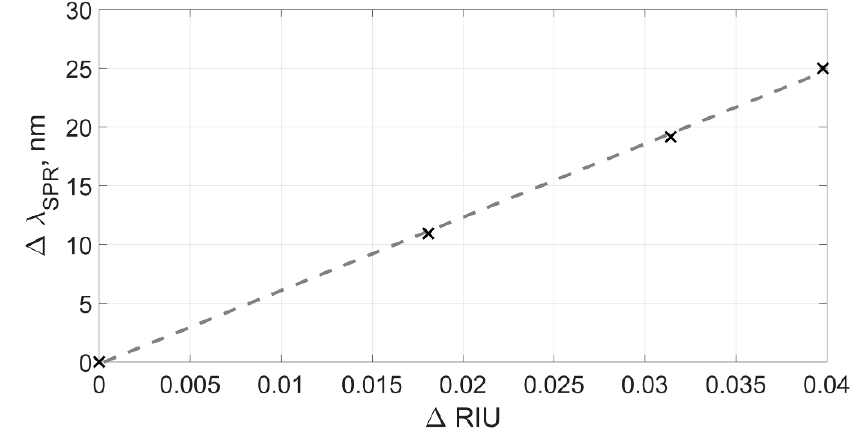
Figure 17. Dependence of the plasmon resonance wavelength shift calculated from the data of the second experiment according to method f (2) .